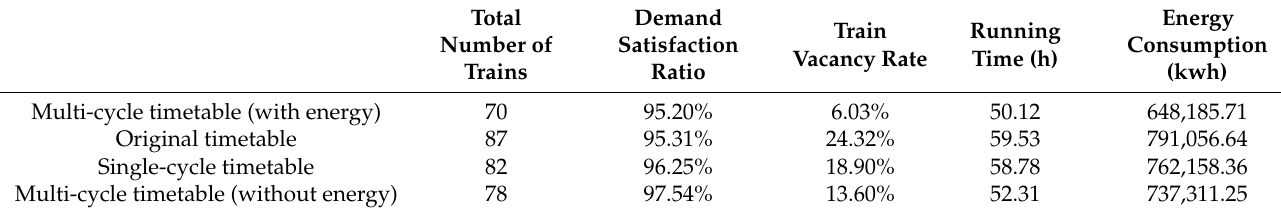
Table 19. Metrics of intercity railway.